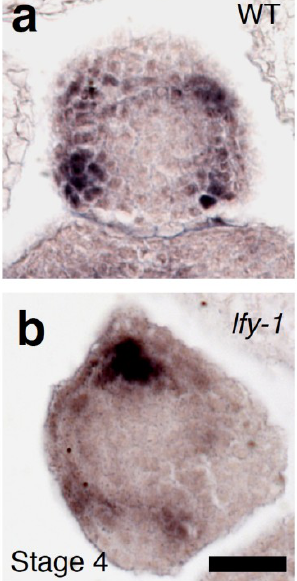
Figure A1. Altered CUC2 gene expression in LFY loss-of-function flowers. ( a , b ) CUC2 expression in wild-type ( a ) and lfy ( b ) flowers at stage 4. Arrowheads denote the boundary between the floral meristem and the sepals. Scale bar, 25